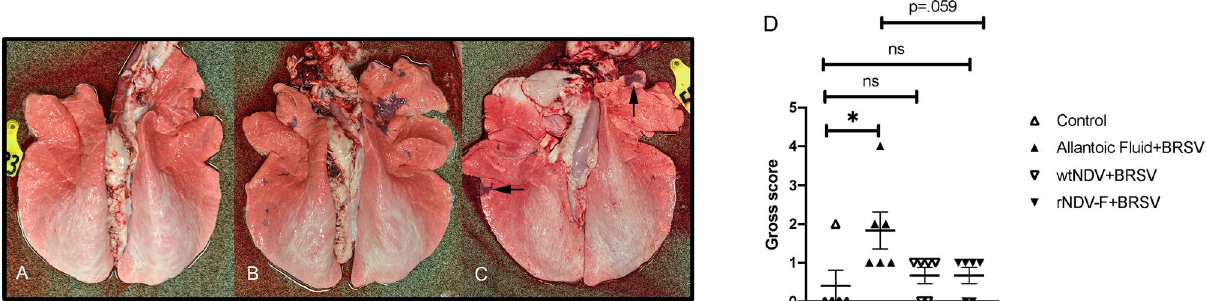
Figure 2. Reduced gross lesions in lungs of rNDV-BRSV F opt vaccinated colostrum-deprived calves. Representative image of lung of non-vaccinated, non-infected calf ( A ). Gross lesions observed at day 7 postinfection with BRSV of a colostrum-deprived calf vaccinated with allantoic fluid (vaccine control) consisting of bilateral, multifocal to coalescing areas of firm, deep plum-red areas of consolidation and atelectasis, with lesions generally present in both cranial and caudal lung lobes ( B ). Lesions were similar, but much reduced in rNDV-BRSV F opt vaccinated calves ( C ). While present (arrows), they are generally limited to cranioventral aspects of right and/or left cranial lobes. In ( D ), the overall gross pathology scores of each group of calves for each individual animal are shown. Statistical analyses were performed using ANOVA. * p < .05, ** p <